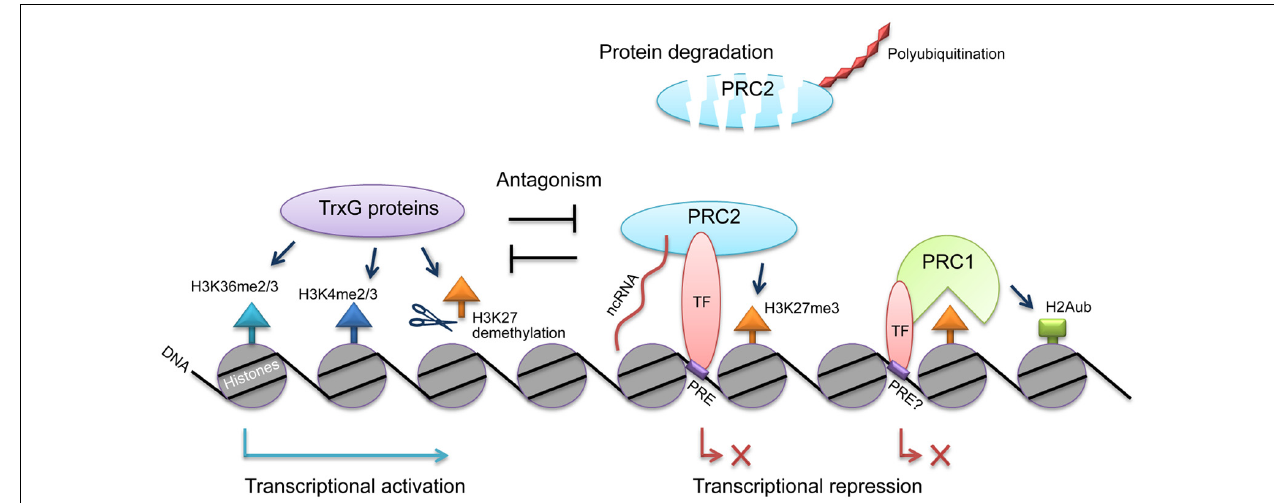
PRC2 component CLF is post-translationally regulated by polyubiquitination, leading to protein degradation. PcG andTrxG antagonize each other to reach a dynamic regulation of gene